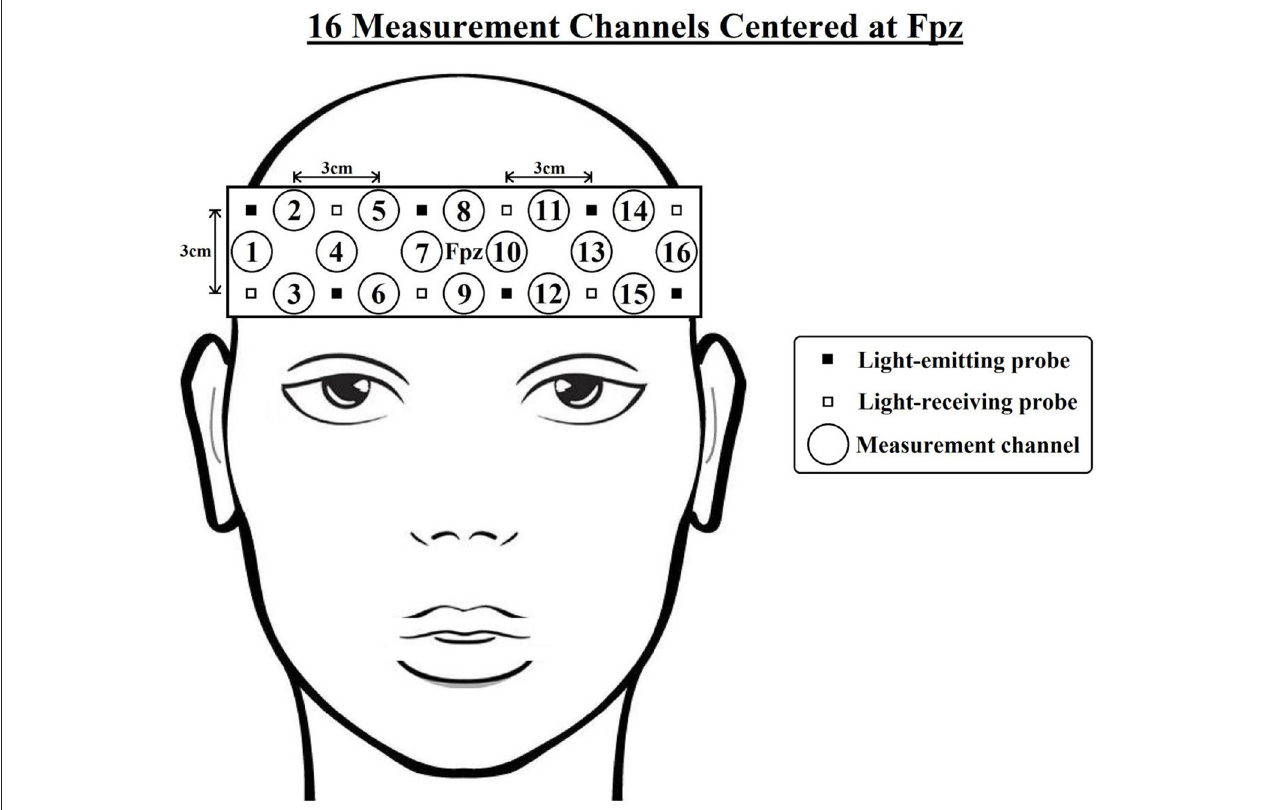
FIGURE 2 | Arrangement of the near-infrared spectroscopy (NIRS) channels. The distance between each pair of emitter and detector probes is 3cm. In accordance with the international 10/20 system, the center of the probe matrix was placed on Fpz, and the probes at the bottom left and right corners were placed around F7 and F8, respectively. Based on previous studies ( Okamoto et al., 2004; Koessler et al., 2009), it was estimated that the outermost channels (e.g., ch1-4,13-16) were located around the lateral prefrontal cortices, and the medial channels (e.g., ch7-10) were located around the medial frontopolar cortex and dorsomedial prefrontal